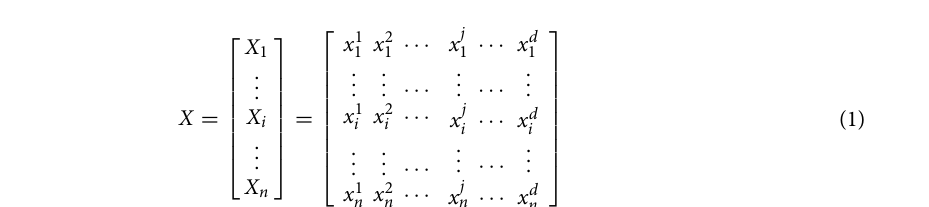
Figure 4. Graphical representation of different reactions in each group of